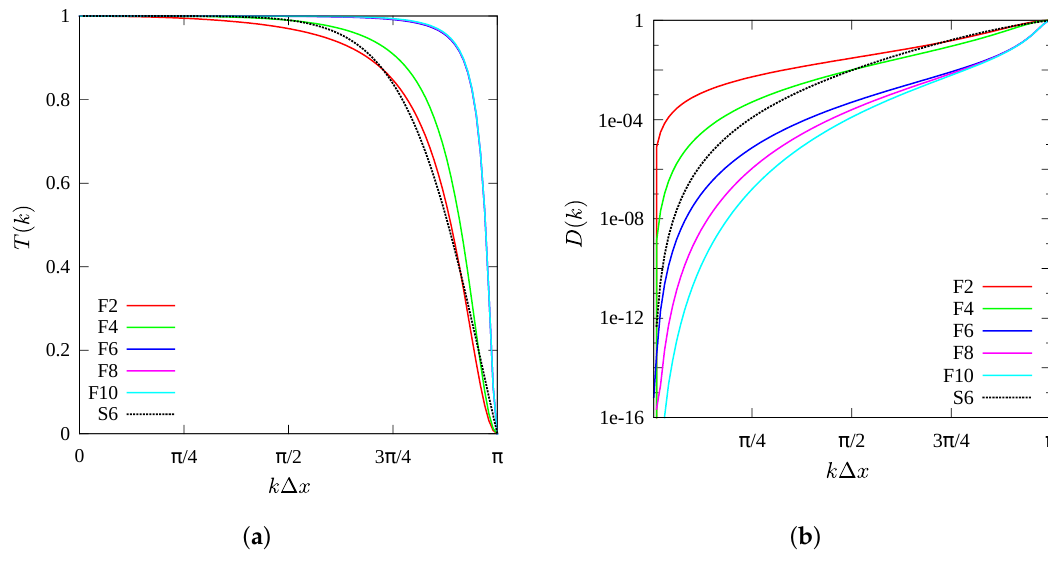
Figure 3. Response and damping functions of filters and scheme. F2–F10 are filters of various orders, and S6 is the sixth-order difference scheme. Filter parameters: α f ( F 2 ) = 0.47, α f ( F 4 ) = 0.48 and α f ( F 6, F 8, F 10 ) = 0.498. ( a ) Filter response functions; and ( b ) filter damping